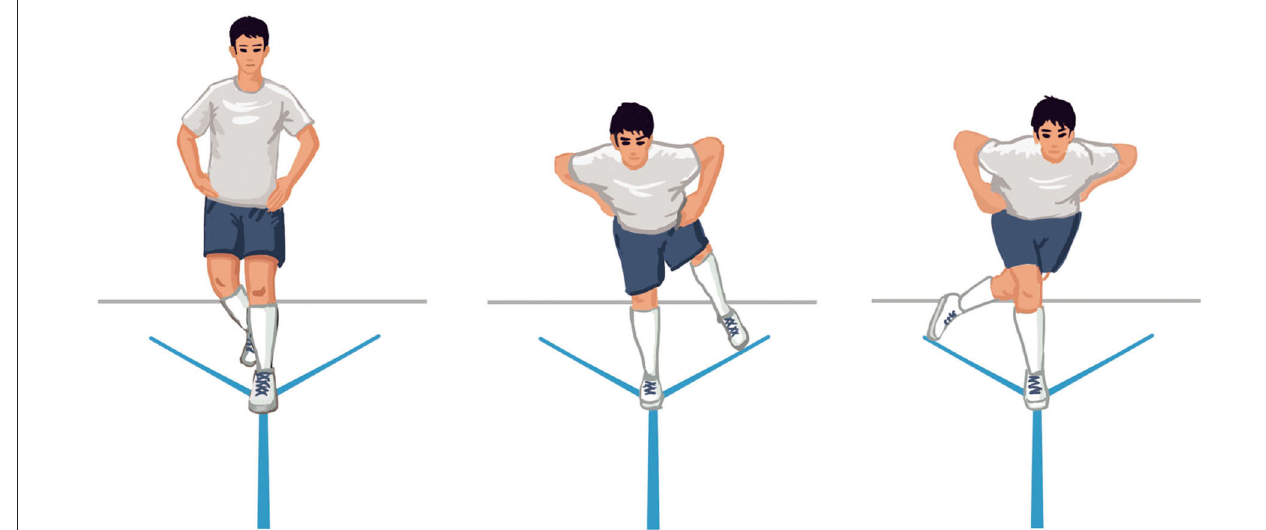
FIGURE 4 | Y-balance test (YBT).